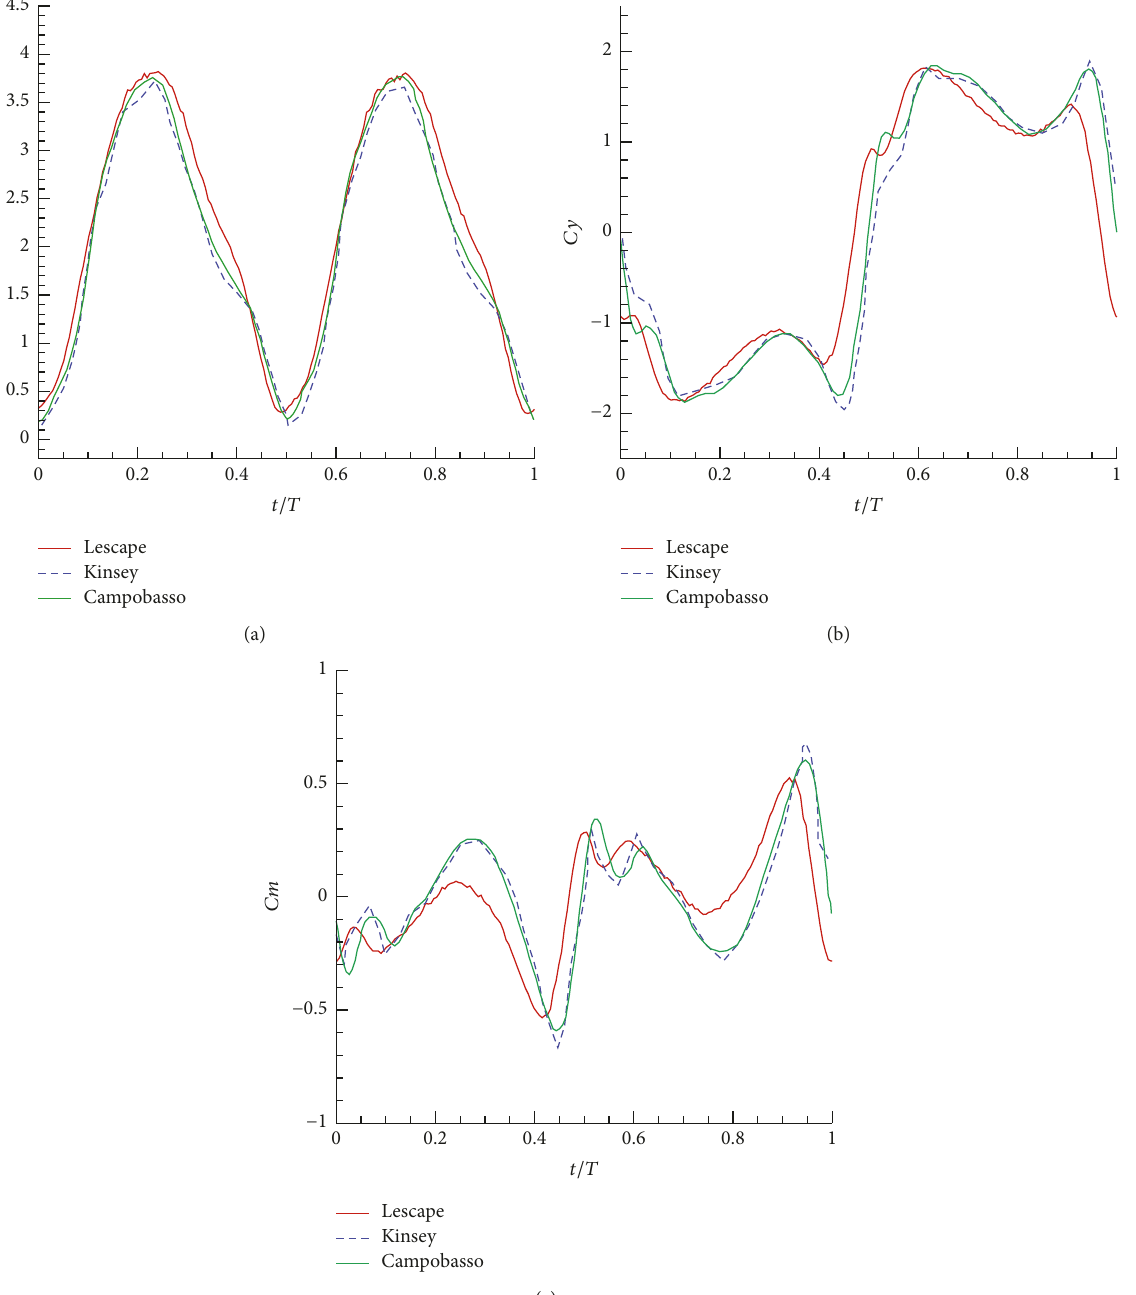
many trajectories are clearly outside the confidence